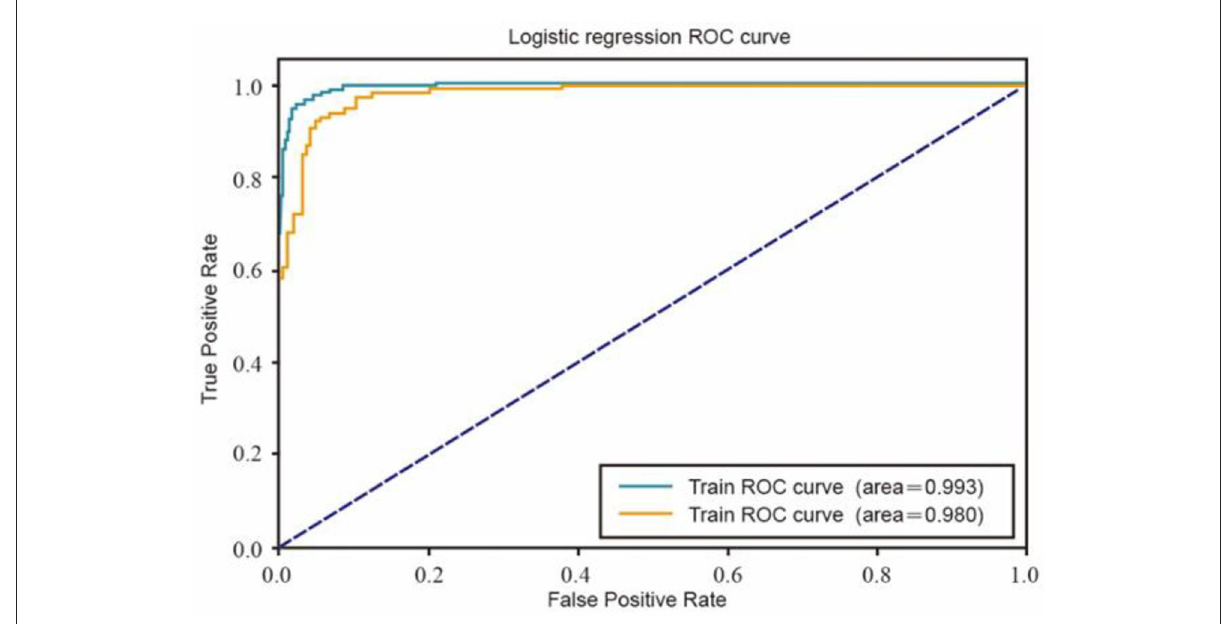
FIGURE2 Logistic regression ROC